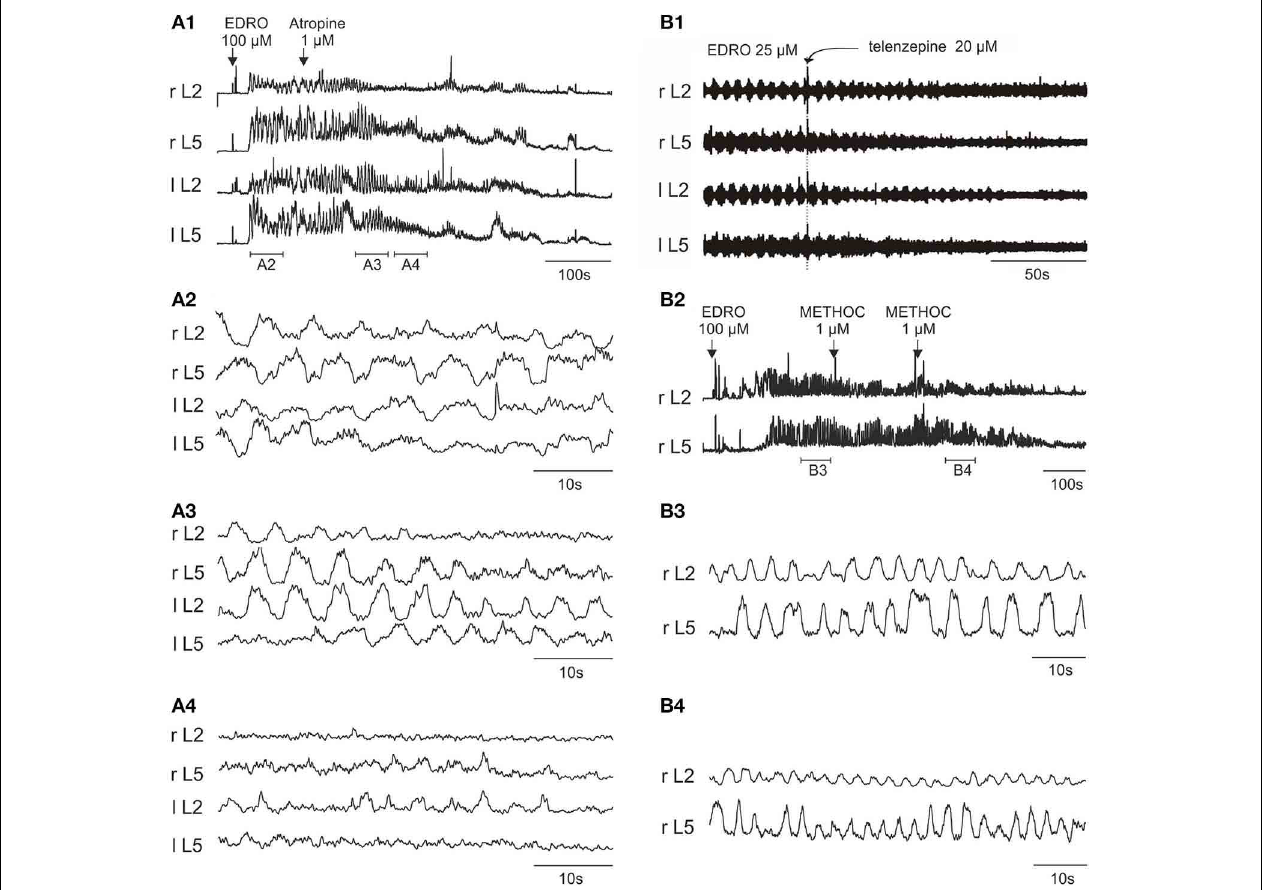
FIGURE 3 | Atropine, telenzepine, and methoctramine effects on the EDRO-induced locomotor rhythm. (A1) Rectified and filtered waveforms showing atropine block of EDRO-induced locomotion. (A2) Baseline locomotor-like activity. (A3) Transient increase in frequency and a decrease in amplitude after 1 μ M atropine. (A4) Progressive reduction of EDRO-induced activity by atropine. (B1) Telenzepine (20 μ M), an M 1 receptor antagonist, blocks EDRO-induced locomotor-like activity only at high doses, decreasing the amplitude but not the frequency of the ENG